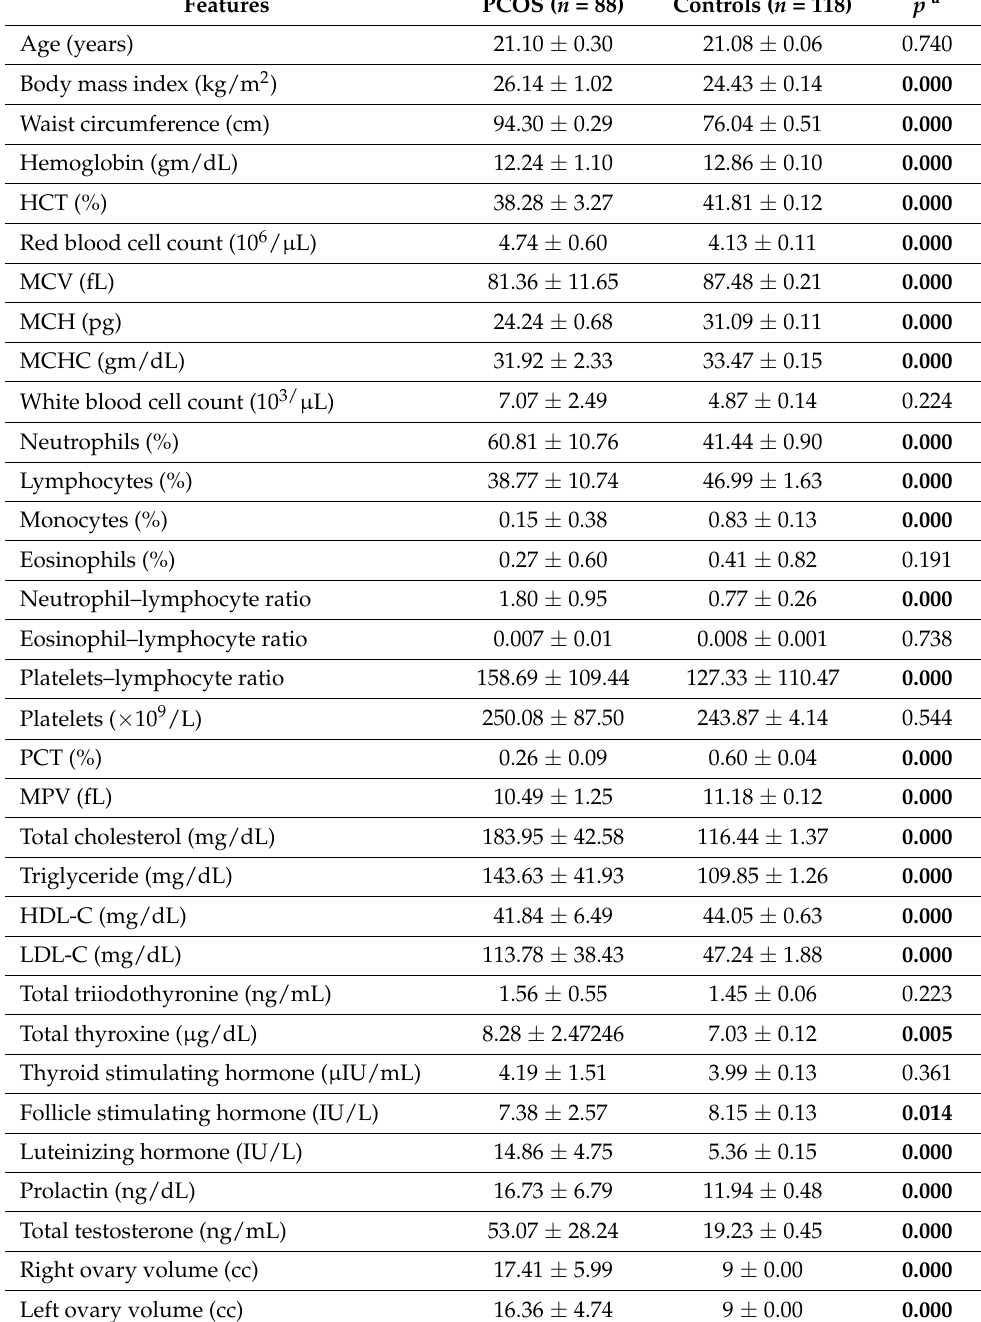
Table 1. Demographic, anthropometric, and clinical characteristics and laboratory investi- gations of women with polycystic ovary syndrome (PCOS) compared to healthy age- and BMI-matching